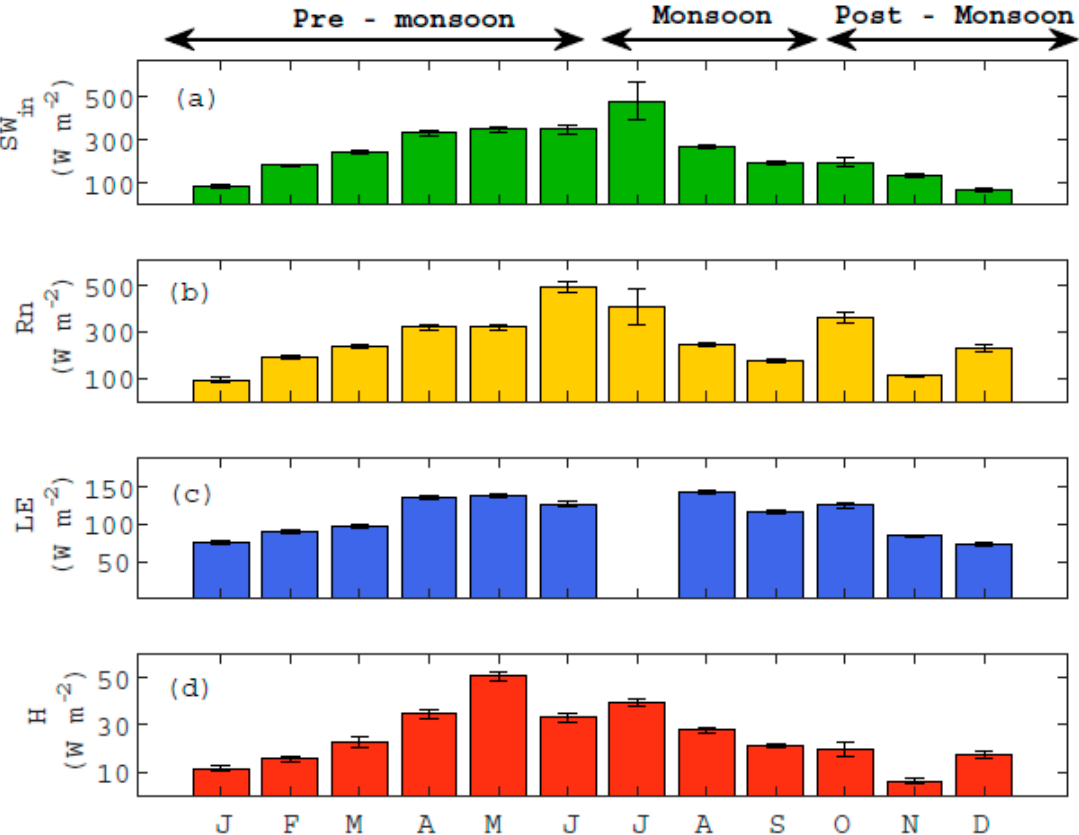
Figure 4. Monthly mean and standard deviation of ( a ) incoming solar radiation (SW in ), ( b ) net radiation (Rn), ( c ) latent heat (LE), and ( d ) sensible heat (H) from January to December 2019. Initial in x-axis from left to right J (January), F (February), M (March), A (April), M (May), J (June), J (July), A (August), S (September), O (October), N (November), and D (December).